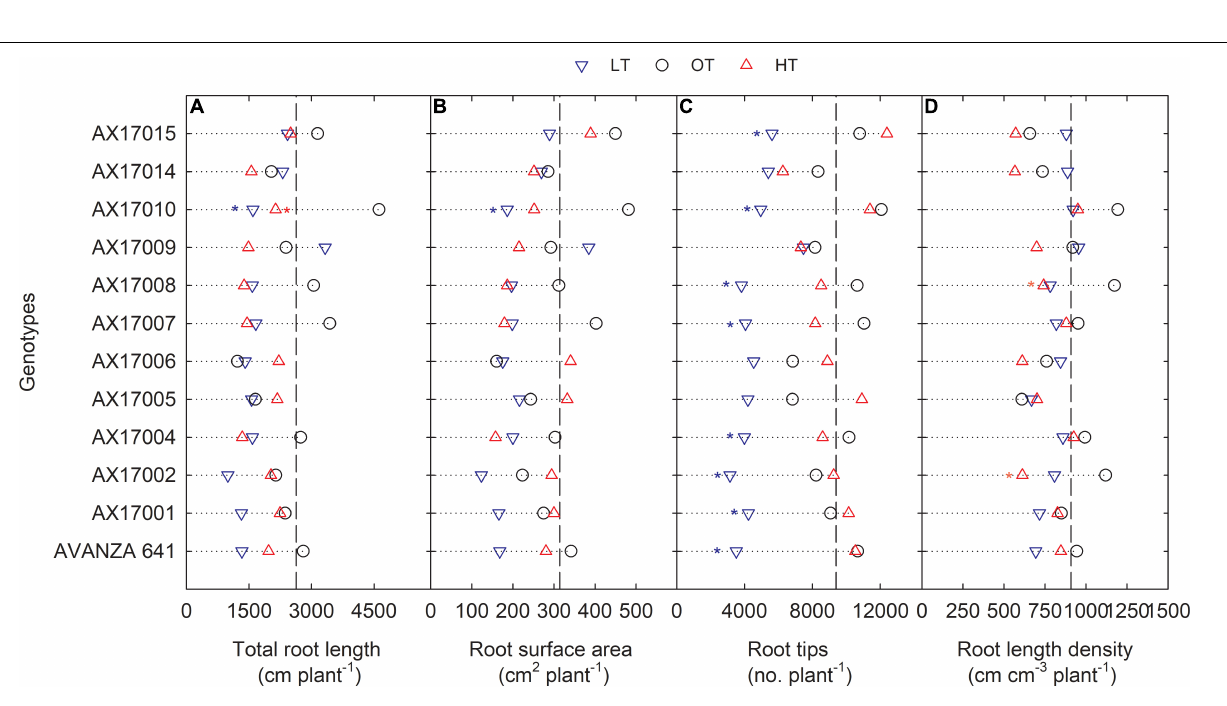
FIGURE 3 | Line plots showing the phenotypic variations of root-related traits such as total root length (A) , root surface area (B) , root tips (C) , and root length density (D) of 12 advanced Brassica carinata genotypes measured 35 days after planting or 24 days after temperature treatments imposition. The dotted middle line indicates the average trait of 12 genotypes under optimum temperature. LT, low temperature; OT, optimum temperature; and HT, high temperature. Asterisk indicates a significant difference between the temperature treatments (blue – between LT and OT; red – between HT and OT) in a genotype at 5% LSD.